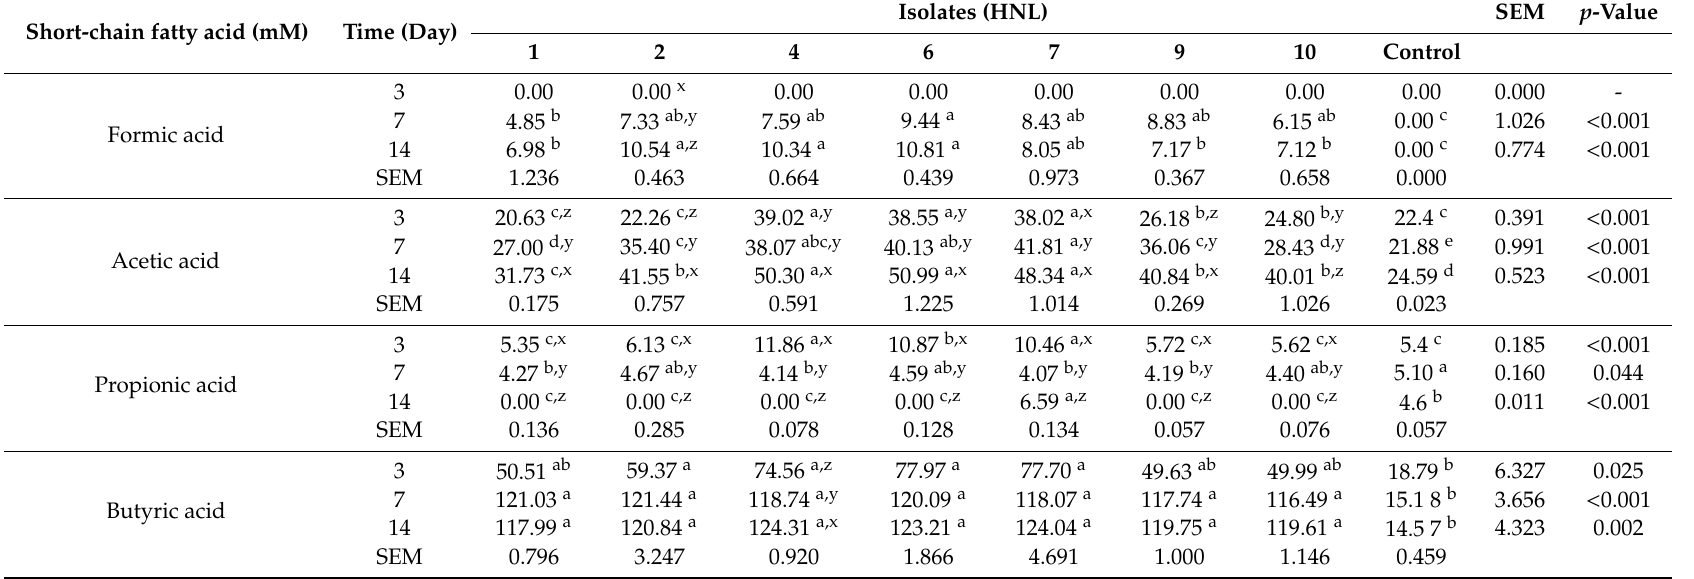
Table 3. Comparison of means of quantified short-chain fatty acids between isolates and between time points. Short-chain fatty acid